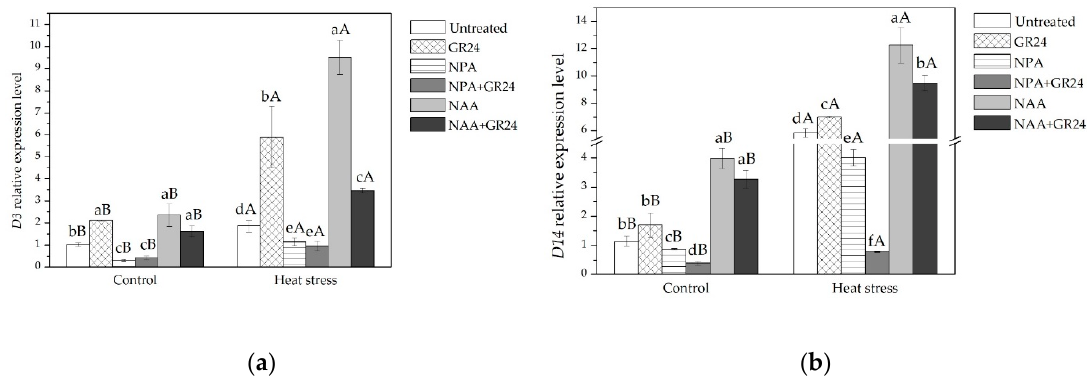
much higher than that of plants under normal temperature conditions (Figure 5).